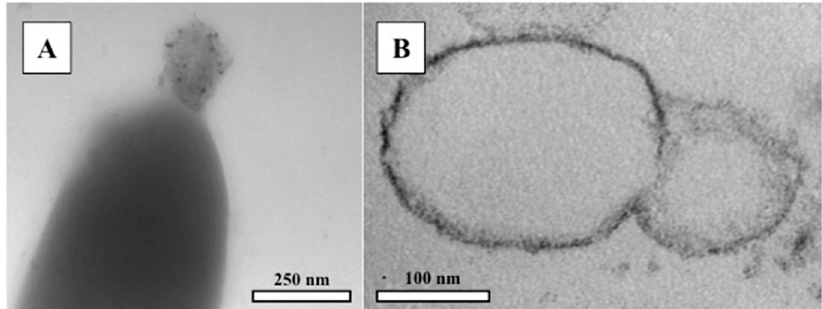
Figure 4. (A ) Whole mount TEM micrograph of immobilized Pt along an outer membrane vesicle blebbing off of the cell envelope (1 h exposure at 5000 µM Pt(II)); ( B ) Ultra-thin section TEM micrograph of Pt immobilisation along the periphery of an outer membrane vesicle (1 h exposure at 5000 µM Pt(II)).